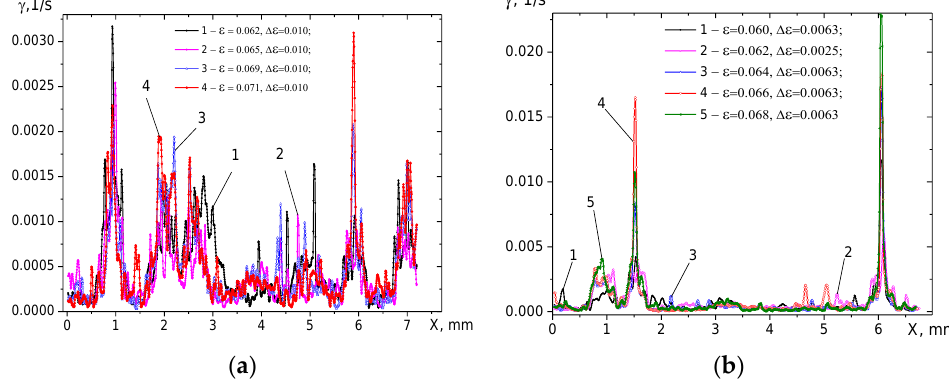
Figure 13. Spatial distribution of CPS rate  (x, y = Y m /2), measured along the midline of Specimen #1 ( a ) and Sample #4 ( b ) at the deformation Stage